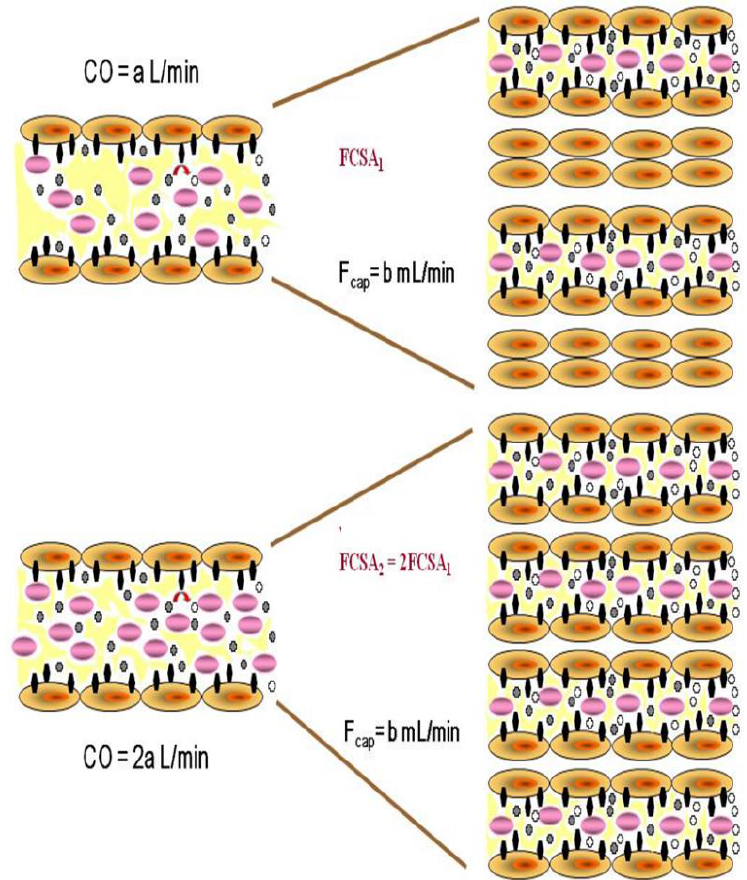
Figure 1. Schematic representation of increased functional capillary surface area (FCSA) during capillary recruitment, as cardiac output (CO) and thus pulmonary blood flow doubles. Individual capillary flow (Fcap) remains unchanged as more capillaries are recruited to accept the total blood flow. However, the surface area and the number of ectoenzyme sites available for substrate metabolism increases. Black symbols represent enzymatic sites, purple symbols represent blood cells, small black ovals represent unmetabolized substrate and small ovals represent metabolized